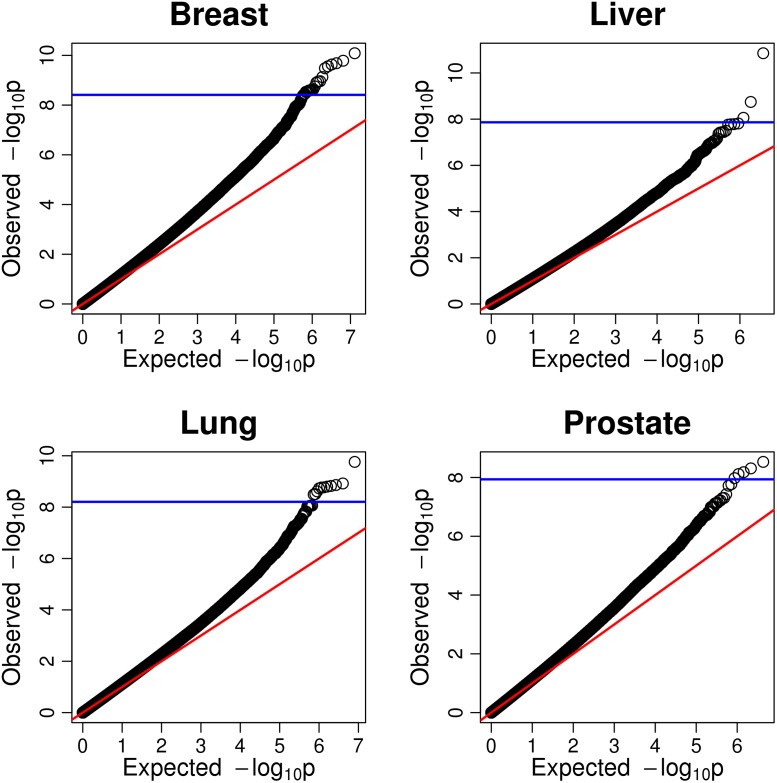
Quantile-quantile plots of regQTL interaction p-values.Quantile quantile plots of the observed p-values for the gene-miRNA-SNP ANOVA interaction tests versus their expected p-value distributions (the uniform distribution), tested in each cancer type. There were approximately 1.29 × 107 unique interactions tested in breast, 3.65 × 106 in liver, 8.03 × 106 in lung, and 4.32 × 106 in prostate cancer. A horizontal blue line indicates the threshold for genome–wide significance under the conservative Bonferroni adjustment. See also S1 Text.